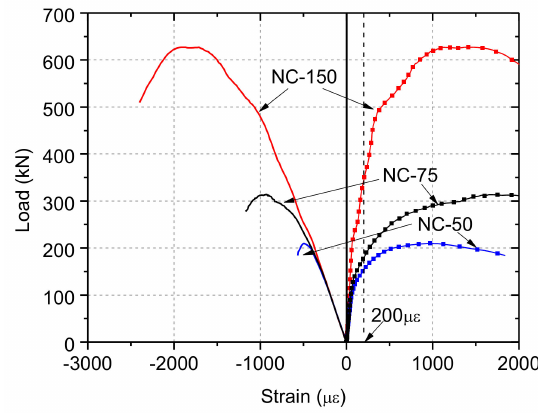
Figure 19. Strain–load curves.